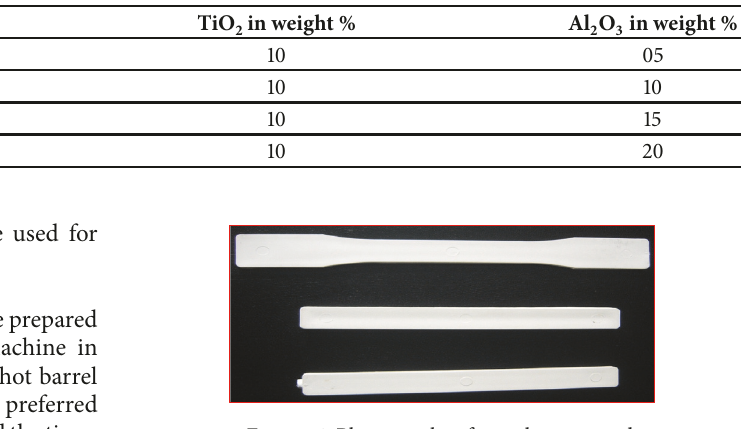
Figure 1: Photographs of samples